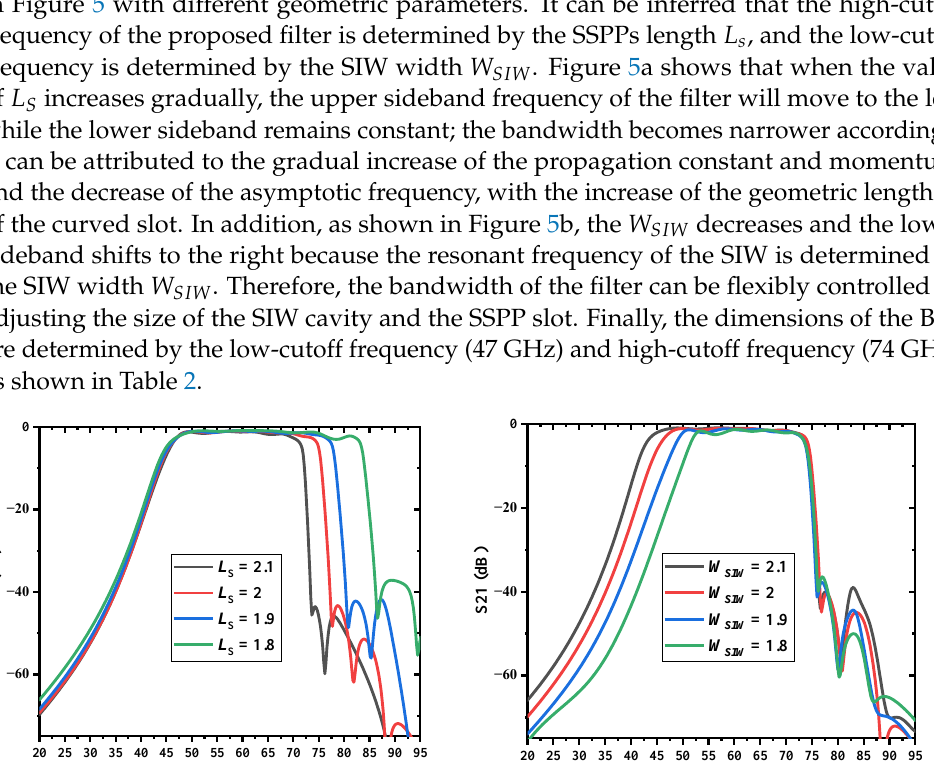
SIW width 𝑊 𝑆𝐼𝑊 . width W SIW